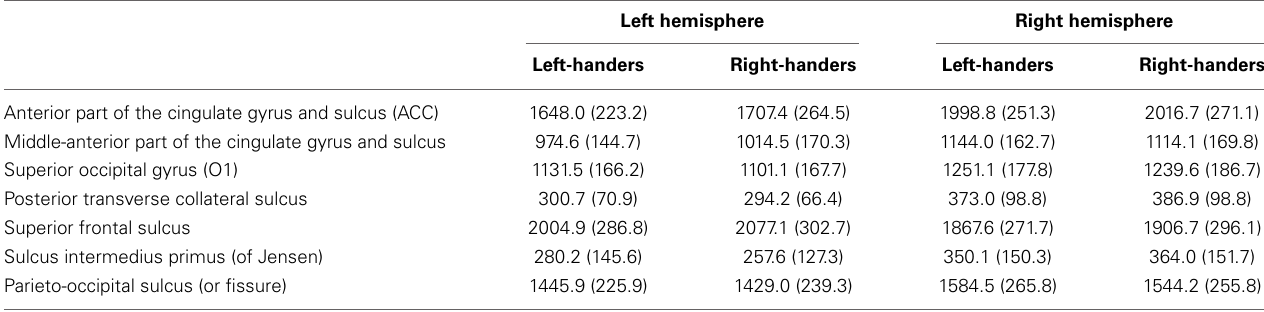
Table 6 | Means (and SD s) for non-candidate cortical regions that achieved nominal significance in ANOVA, by hemisphere and handedness